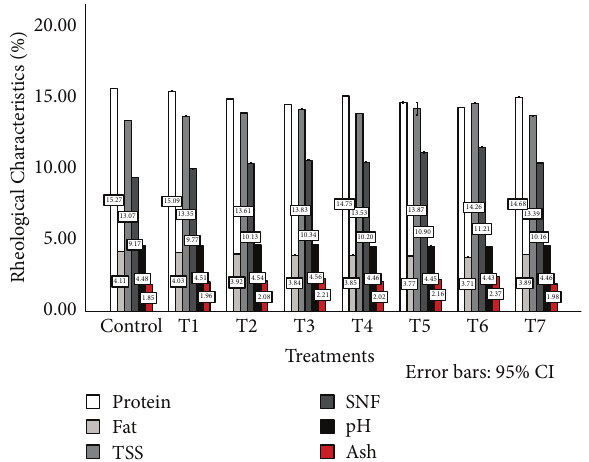
Figure 3: Effect of adding APP and PPP on the biological prop- erties of